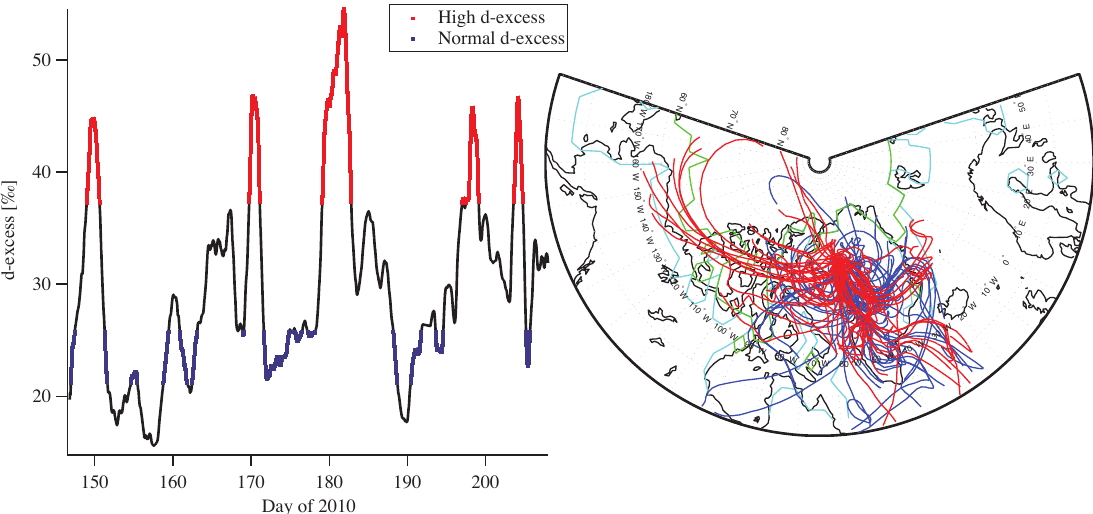
Fig. 5. The left panel shows the observed d-excess from the LGR analyzer smooth using a 24h moving window. Red indicates periods with high d-excess defined as d-excess being larger than 3 standard deviations from the mean value of the main cluster. Blue indicates periods of normal d-excess defined a being within ± 0.5 standard deviation of the mean value of the main cluster. The right panel shows back trajectories calculated using the FLEXTRA model 5 days back (Stohl et al., 1995, 1998). Red back trajectories correspond to periods of high d-excess while blue trajectories correspond to periods of normal d-excess. Cyan solid line indicates sea-ice extent (concentration > 15%) for May while green solid line indicates sea-ice extent for August based on data from Nimbus-7 SSMR and DMSP SSM/I passive microwave data (Fetterer et al.,